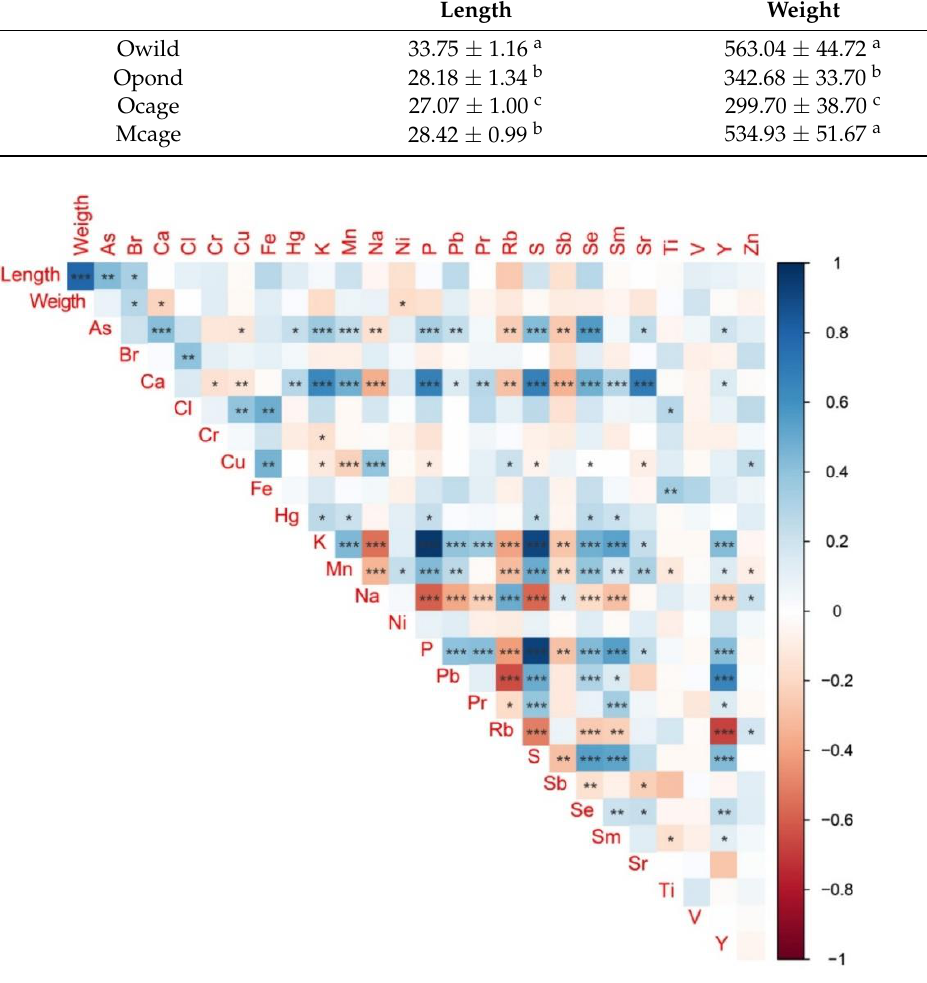
Figure 5. Spearman correlation matrix (ρ) between the morphometric variables (fish total length and weight) and the elemental concentrations (mg/Kg) detected in the Sparus aurata muscle (the asterisks denote significant correlations at p < 0.05 *, p < 0.01 ** and p < 0.001 ***). Some element concentrations (mg/Kg wet weight), such as As, Br, K, P, Pb and Se, showed clear variations in concentration among the origins, while others did not (Figure